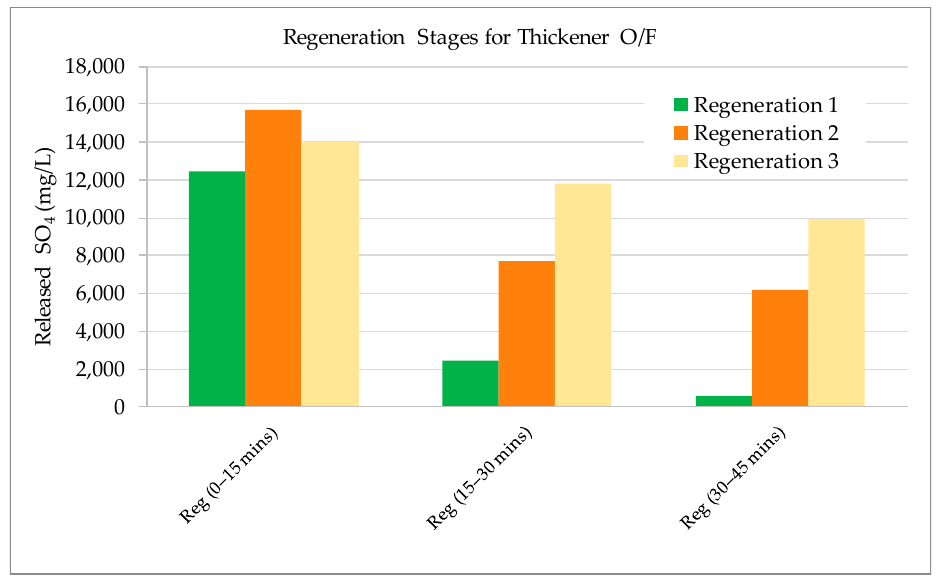
Figure 14. Desorption of sulphate ions from the resin in the regeneration stages applied after the adsorption experiments on the Thickener Overflow (O/F).